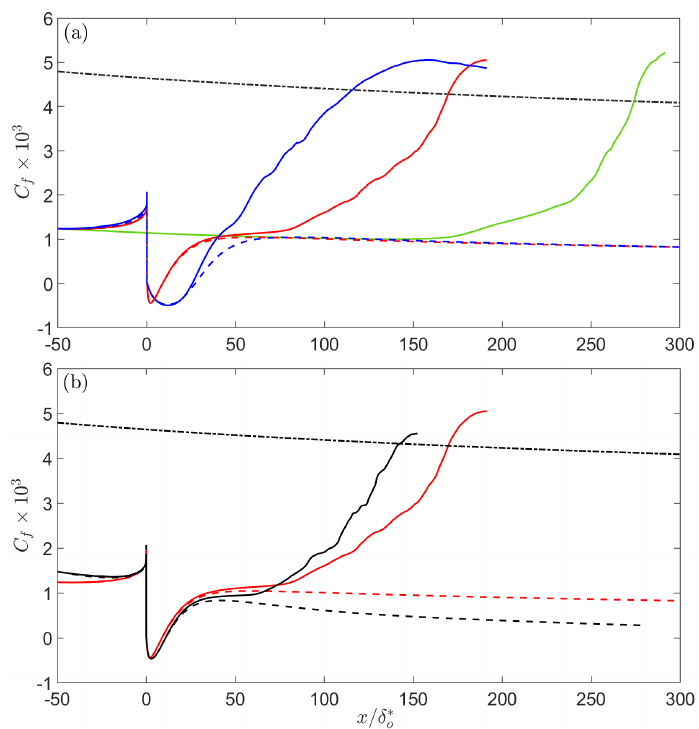
Figure 7. Skin − friction coefficient, C f . ( a ) Step-height effect; ( b ) influence of variable U e . Flat plate; , small step; , large step; , small step, variable U e . The solid line is the transitional flow, the dashed line the corresponding laminar flow. Turbulent correlation